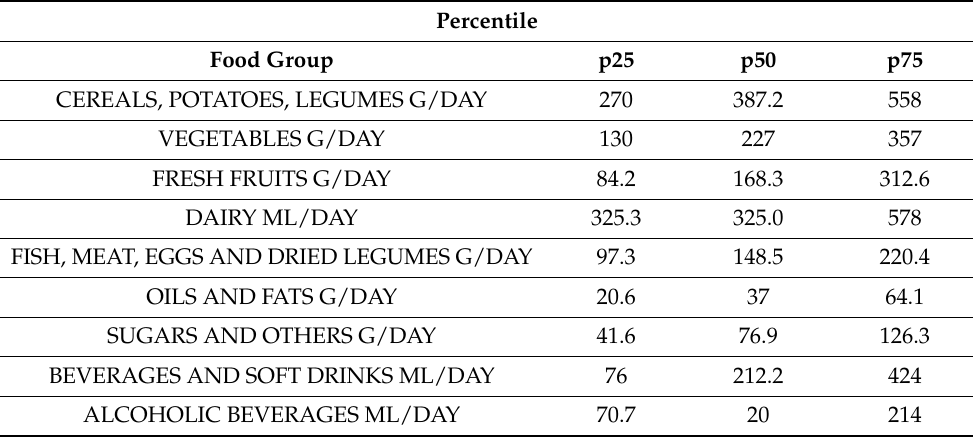
Table A2. Consumption data (25th, 50th and 75th percentiles) according to ENCA 2010.